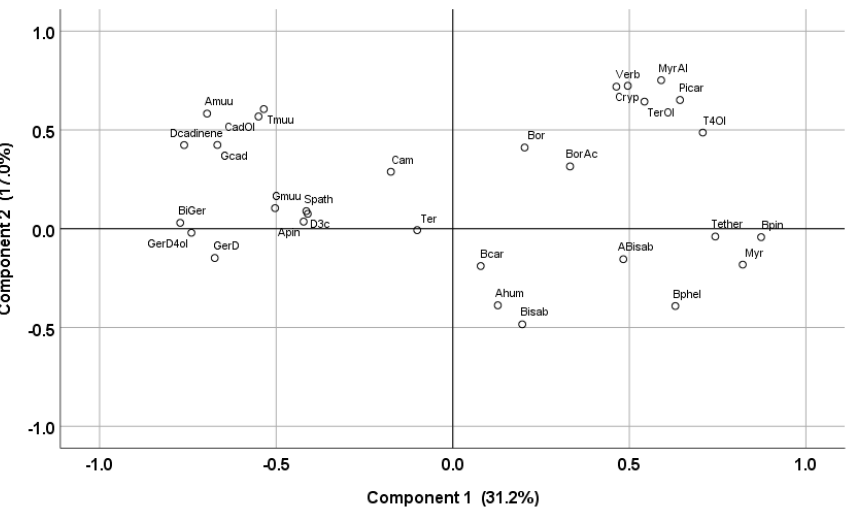
Figure 1. Essential oil compounds loading on the first two axes of a principal component analysis of P. cembra essential oils.